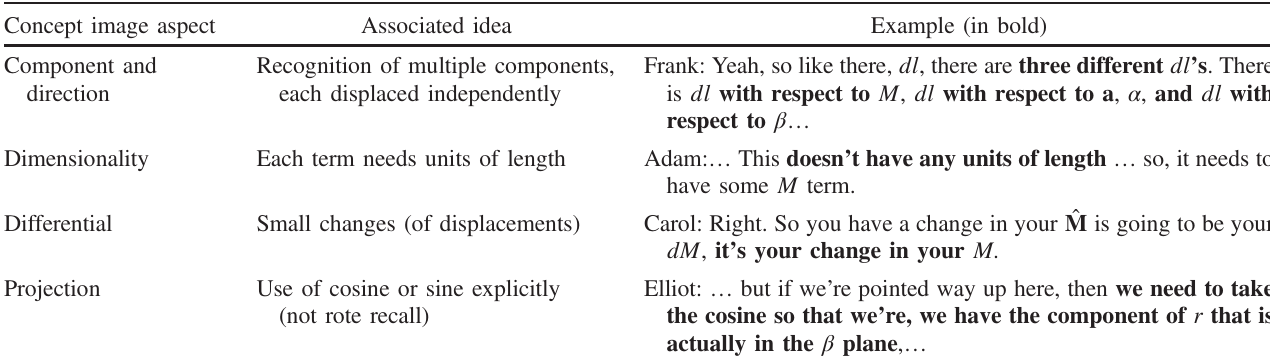
TABLE I. Aspects of students ’ concept image of a differential length vector in a non-Cartesian coordinate system [18].